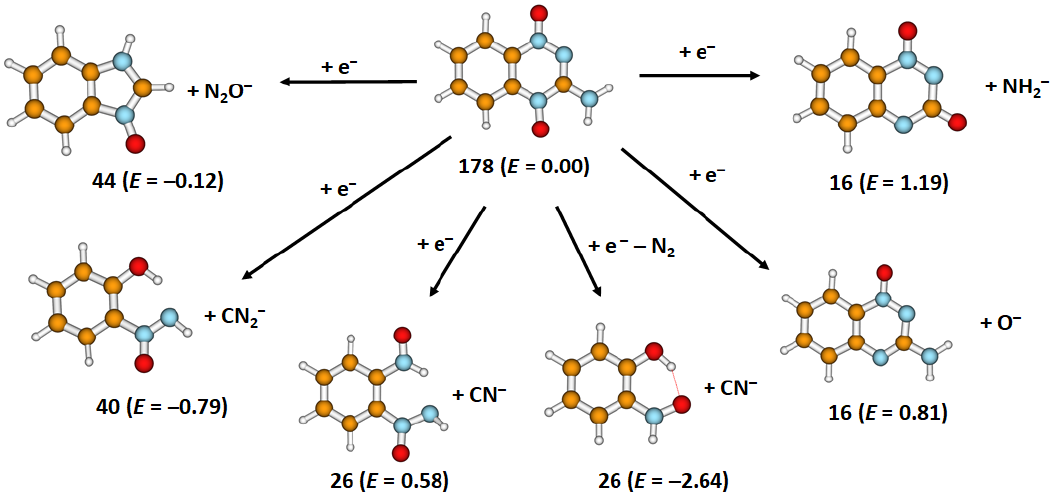
Figure 5. Suggested fragmentation pathways producing small anions after electron attachment to tirapazamine; the mass (in u) and energy E (in eV) of the respective anions are given. Calculated at the B3LYP/aug–cc–pVDZ level of theory.